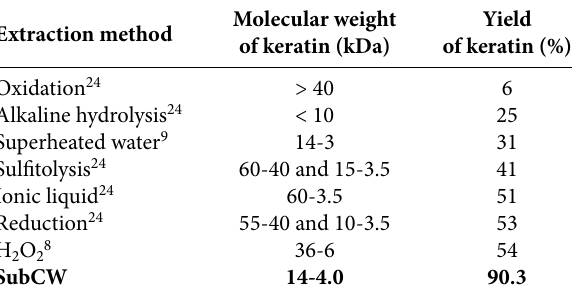
Table 5. Keratin molecular weights determined by SDS-PAGE elec- trophoresis and its yields isolated in different ways. Extraction